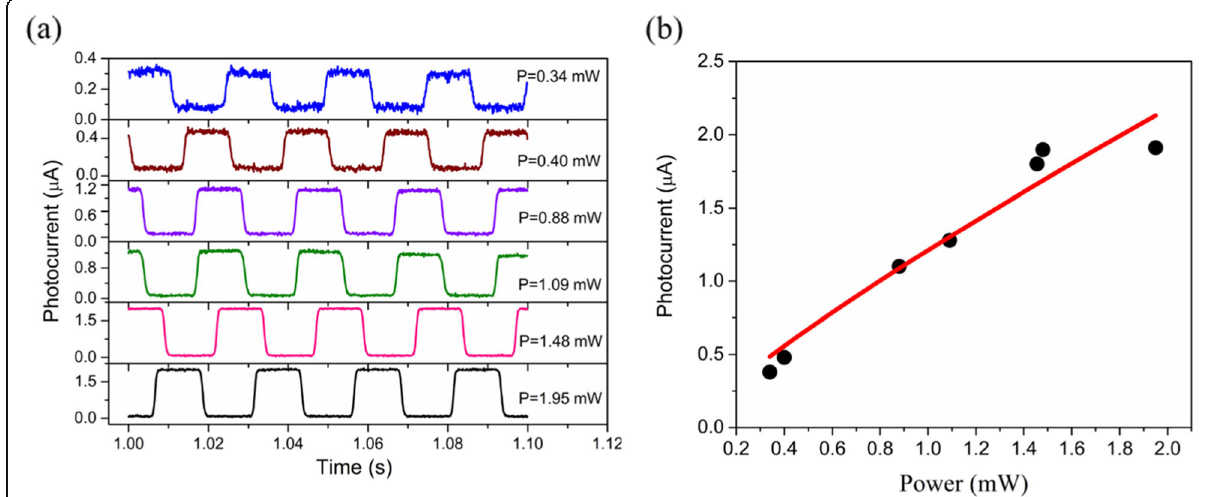
Fig. 5 a The time-dependence photocurrent measurements under the different power of incident light. b The power dependence of the photocurrent ’ s properties. The results indicate that the GRN photodetector possessed a high photosensitivity property achieving mW-level input optical power